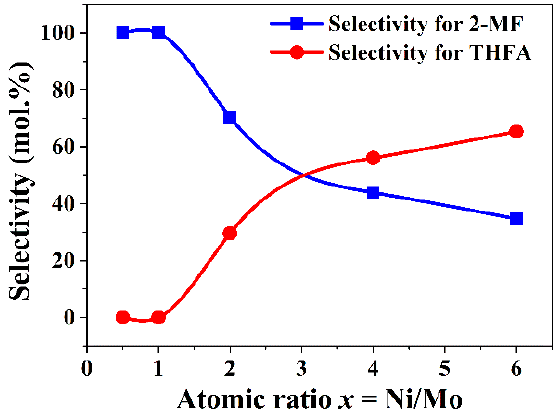
Figure 13. Dependence of selectivity for 2-MF and THFA formation from FA on the atomic ratio x = Ni/Mo. Reaction conditions: T = 150 °C, P = 6.0 MPa, m cat = 1.000 g, and furfural/isopropanol molar ratio equal to 0.033.